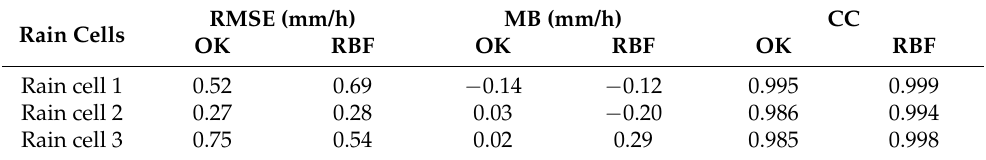
Table 3. The results of the joint network of ESLs and HMLs retrieving the different rain cells. RMSE (mm/h) MB (mm/h) CC Rain Cells OK RBF OK RBF OK RBF Rain cell 1 0.52 0.69 − 0.14 − 0.12 0.995 0.999 Rain cell 2